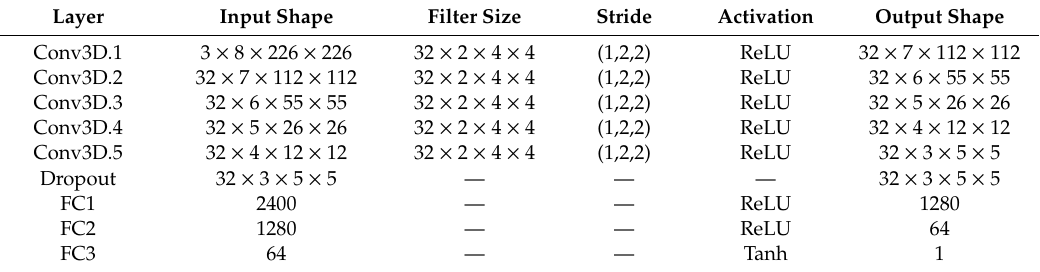
Figure 4. Flow chart and architecture of the TC-3DCNN (three-dimensional convolutional neural network) model. Table 1. Model architecture of TC-3DCNN (including five convolutional layers and three fully connected (FC) layers).